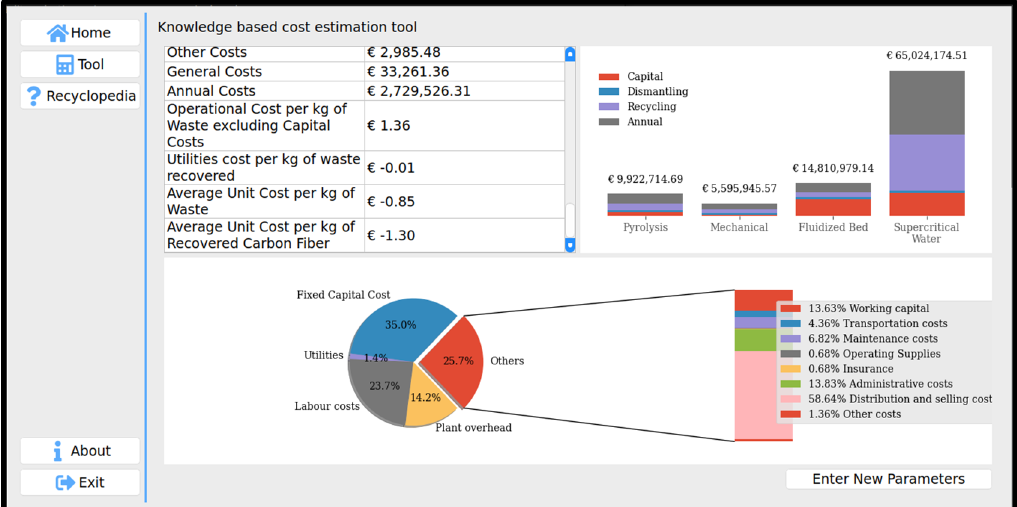
Figure 5. Cost estimation results.